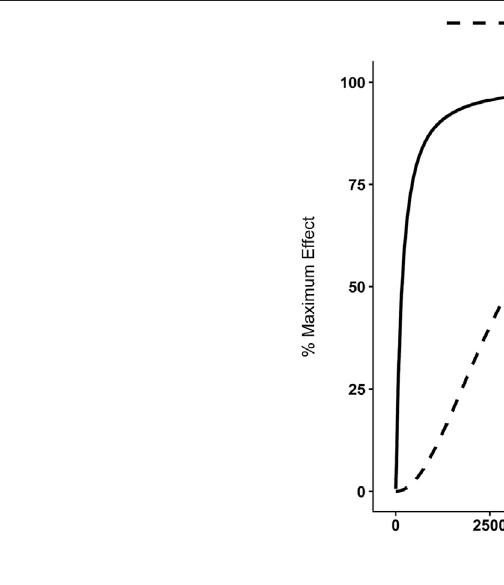
Frontiers in Pharmacology |